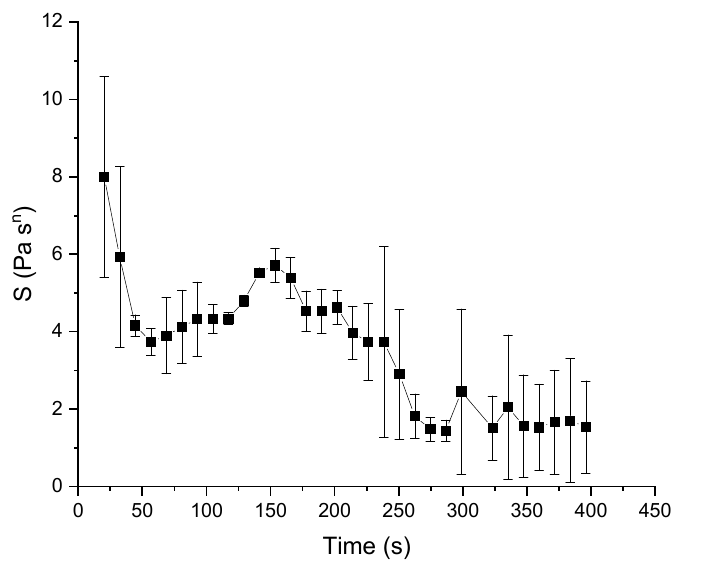
Figure 5. Gel strength S (fit of the relaxation modulus according to Bhattcharya et al. [24]) calculated from the relaxation steps during the shear kneading process of standard wheat flour and water. Means are shown with standard deviation (n = 3).